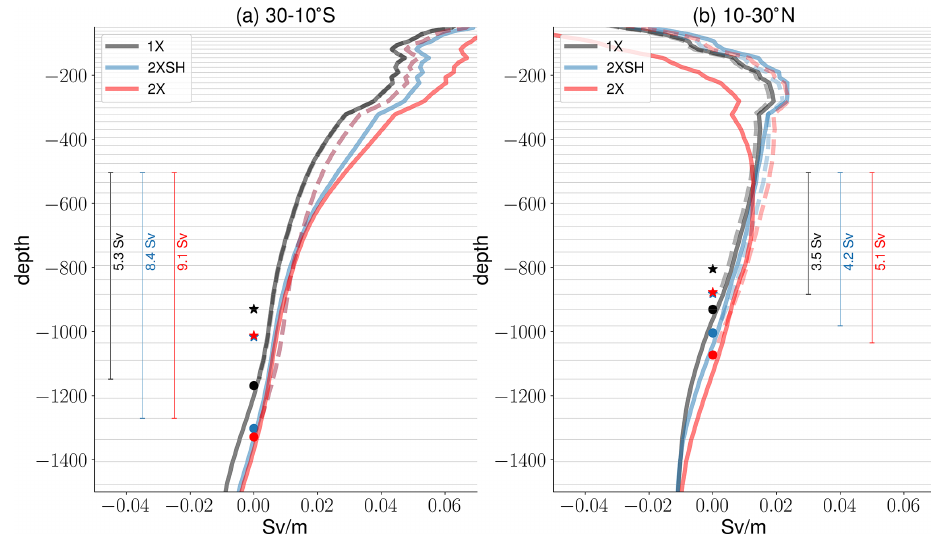
Figure 8. The meridional averages in the Southern Hemisphere ( a , 30–10 ◦ S) and in the Northern Hemisphere (b , 10–30 ◦ N) of the time- mean (1991–2010) vertical derivative of the AMOC streamfunction ∂ψ in the 1X experiment (black), 2XSH experiment (blue), and 2X ∂z experiment (red). We exclude the surface Ekman layer. The circles show the meridional averages of the level of no motion η ψ and the stars show the meridional averages of the pycnocline scale η ρ . The dashed lines represent the velocity profiles that arise from the displacements 2 ψ of the level of no motion η ψ while the velocity shear ∂ is held constant (1X) in the sense that we use it as the reference vertical velocity ∂z 2 shear that is forcing-invariant. The time-mean vertical velocity shear of the 1X experiment is thus integrated from the level of no motion in the 2XSH and 2X experiments to obtain velocity profiles. Note that in the Southern hemisphere the dashed blue line and the dashed red line fall on top of one another. We indicate the transport (Sv) at the deeper levels by the annotation at the vertical bars, which show the respective depth range. The thin gray lines indicate the vertical model